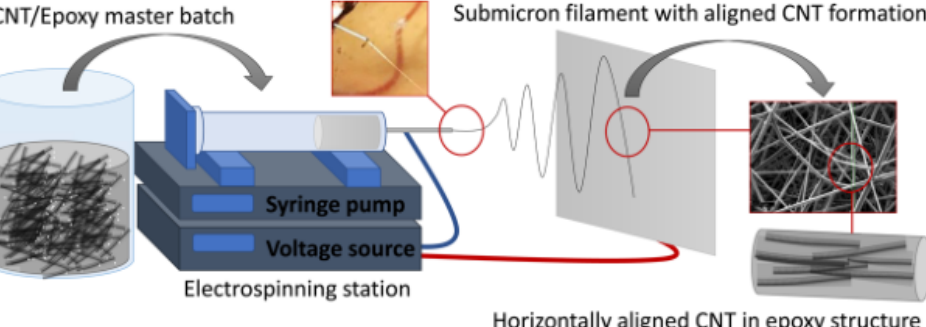
Figure 15. Precess of electrospinning for filament with aligned CNT formation. Reproduced with permission [41]. Copyright 2021, American Chemical Society.